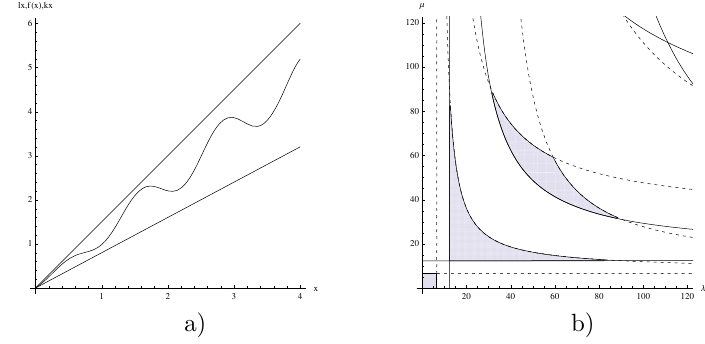
Figure 4. a) The graphs of f ( x ) and the linear functions kx and lx, k = 1 . 5 , l = 0 . 8; b) (cid:2) Intersections D ( l ) i D ( k ) i , k = 0 , 1 , 2.